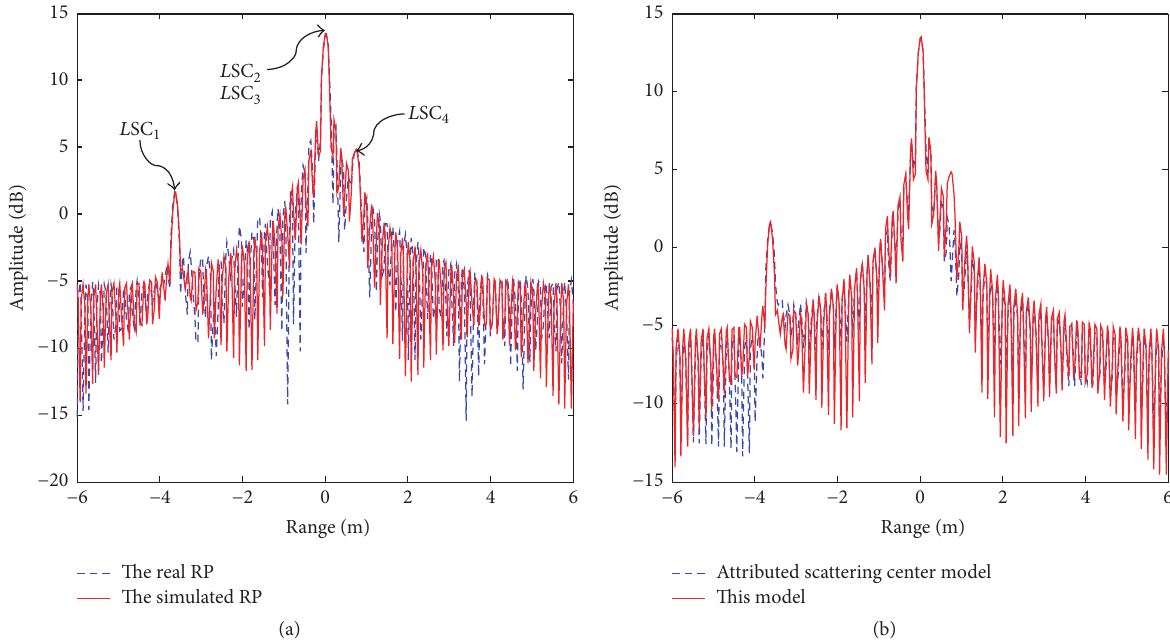
Figure 12: Comparison with the RP. (a) Comparison of the simulated RP with the real RP; (b) comparison of the RP obtained by the attributed scattering center model with the simulated RP by this